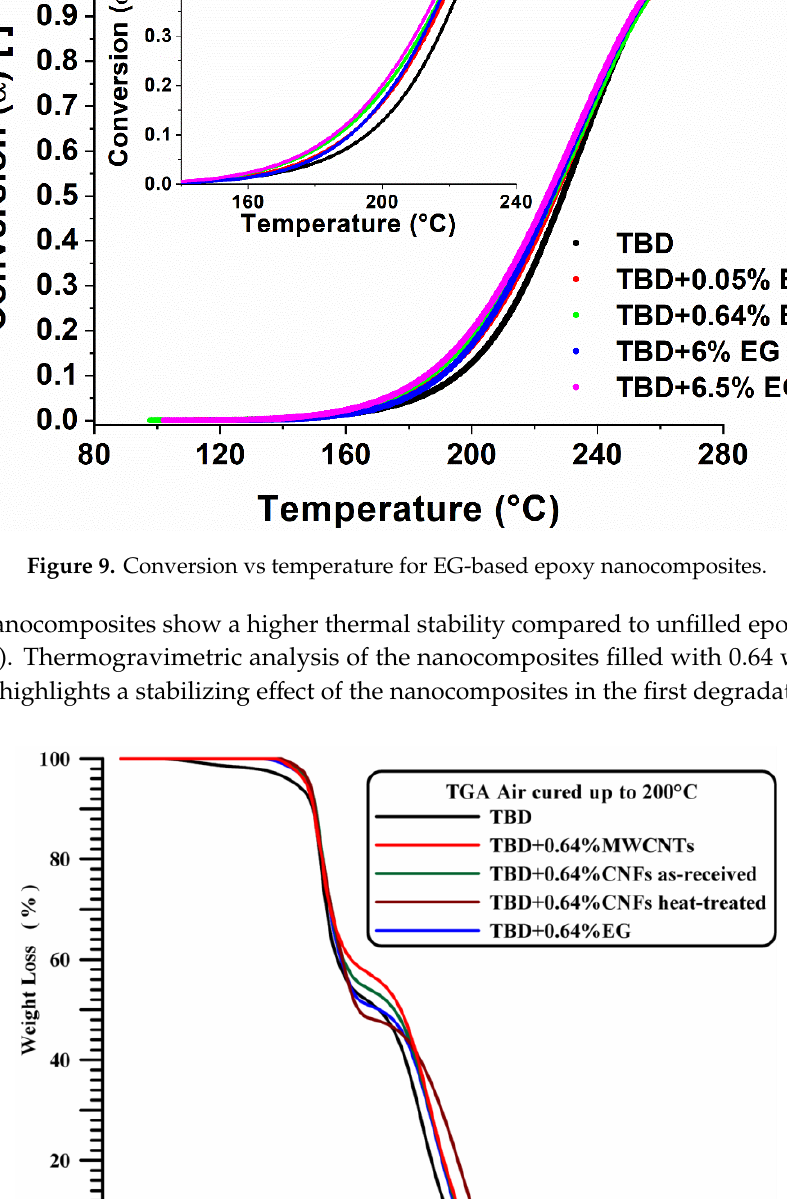
Figure 11. TGA curves in air of neat and EG based nanocomposites. AFM microscopy allows us to analyze the morphology and the properties of the sample surface up to the atomic scale [34,35]. Figures 12, 13 and 14 show the AFM micrographs and the corresponding 3D profiles of the fracture surface of the TBD+3%EG, TBD + 0.64%MWCNTs, and TBD + 1%CNFs heat-treated epoxy samples, respectively. We have chosen to investigate the morphology of these samples because the amount of nanofiller in the mentioned formulations is well above the electric percolation threshold [3,5,6] and therefore represents a good reference to evaluate the effectiveness of the nanofiller dispersion in the resin. In order to obtain reproducible results, the whole surface of the epoxy nanocomposites has been analyzed. In particular, several points of the